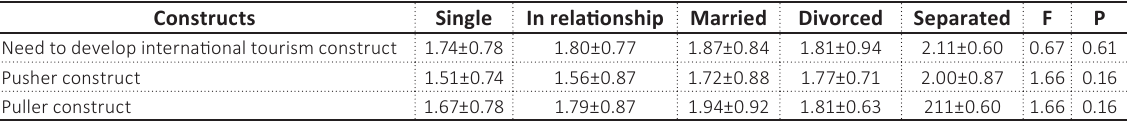
Table 13. Marital status difference analysis Constructs